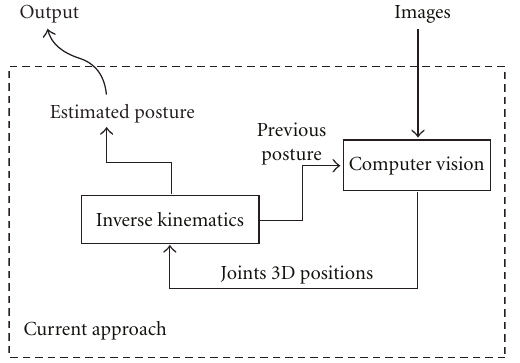
Figure 2: Our approach: Adding image constraints to inverse